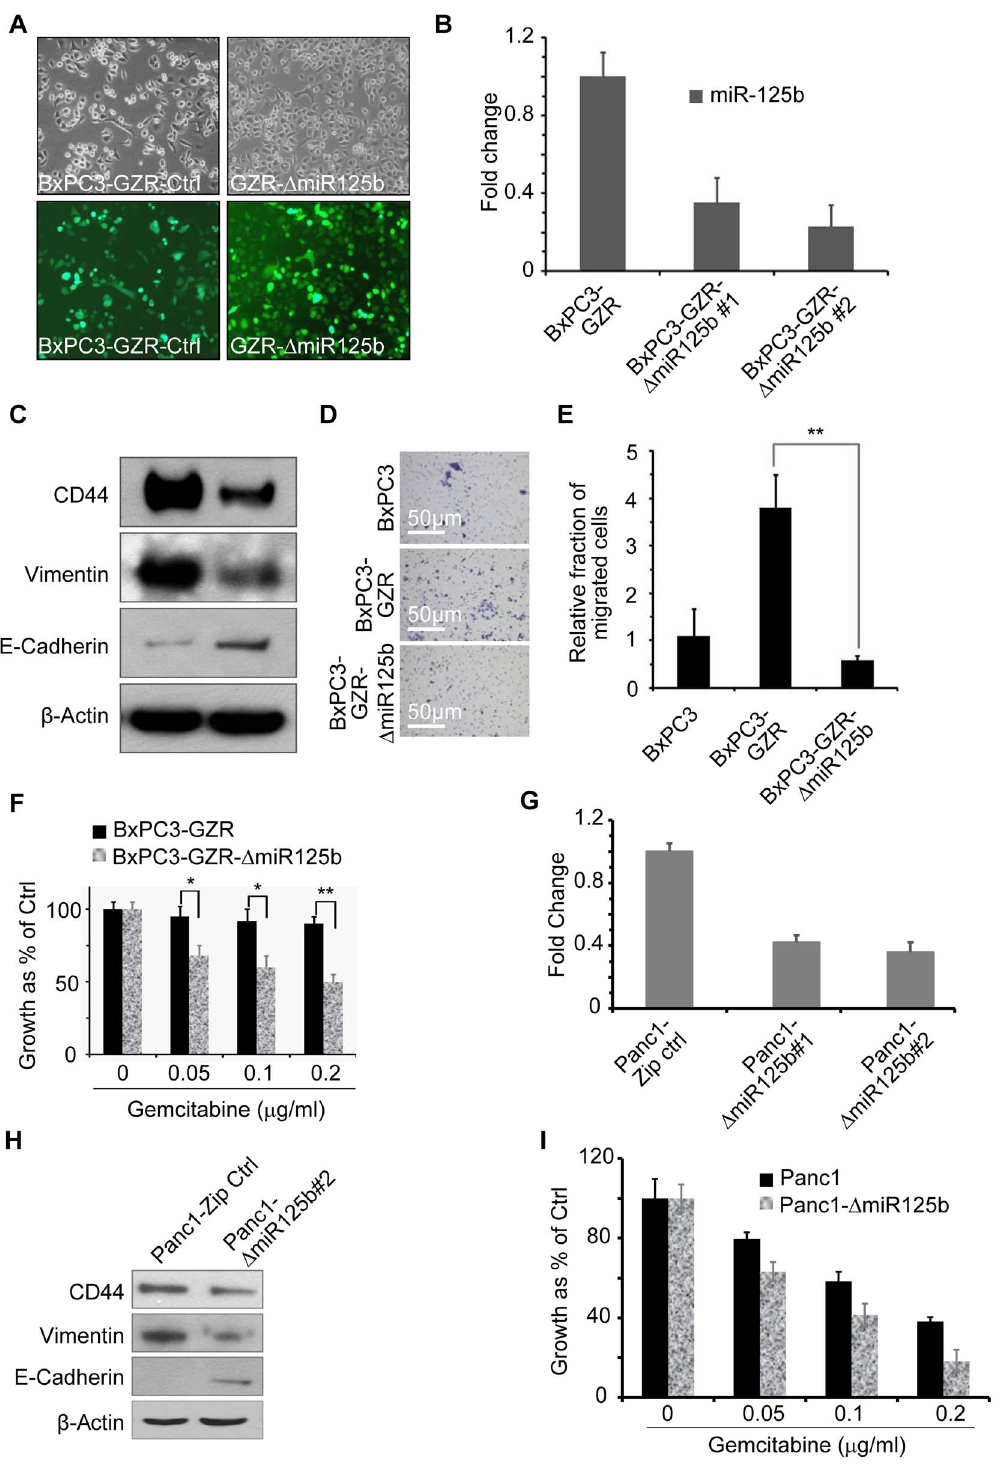
Figure 4. Knockdown of micro-RNA-125 reverses the mesenchymal phenotype and increases the drug sensitivity in BxPC3-GZR cells. A. Establish the Lenti-viral based stable cells expressing anti-miR-125b in BxPC3-GZR (Zip-control and miR-125b knock-down). B. TaqMan qPCR assays showing the knockdown of miR-125b in BxPC3-GZR-Zip ctrl cells compared to BxPC3-GZR D miR-125b cells. C. Expression of anti-miR-125b (Zip technology, SBI) decreases the expression of EMT and stemness marker monitored by Western bolt assays. Panels D and E show the attenuation of cell migration by knocking down miR-125b expression. Images were taken after crystal violet staining of migrated cells and the data was plotted as a graph (Bar=50 m m). F. Knockdown of miR-125b increases response to gemcitabine. BxPC3-GZR-ZiP-Ctrl and BxPC3-GZR D miR-125b cells were treated with gemcitabine at different concentrations and the MTT assays were performed after 96 hours of treatment. G. Knockdown of miR-125b in Panc-1 cells. Lenti-viral based stable cells were generated to inhibit miR-125b expression (Zip technology,). TaqMan qPCR assays were performed to measure the expression of miR-125b in Zip-control Panc-1 cells and knock down cells (Panc-1 D miR-125b). H. Inhibiting miR-125b decreases CD44 and